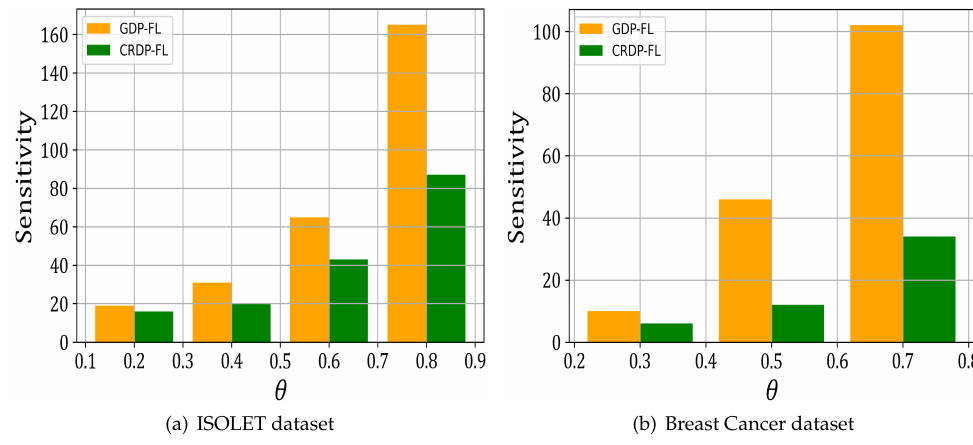
Figure 5. Correlated sensitivity comparison of the algorithms under different feature selection